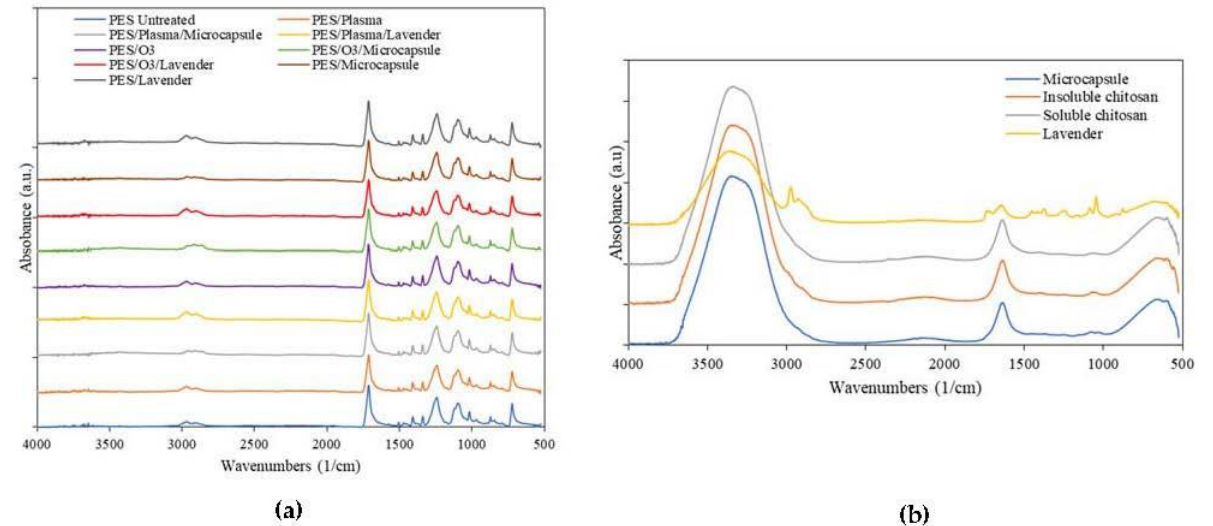
Figure 3. FTIR spectra of the ( a ) polyester treated and untreated with and without microcapsules and ( b ) microcapsules and compounds isolated from the constitution.